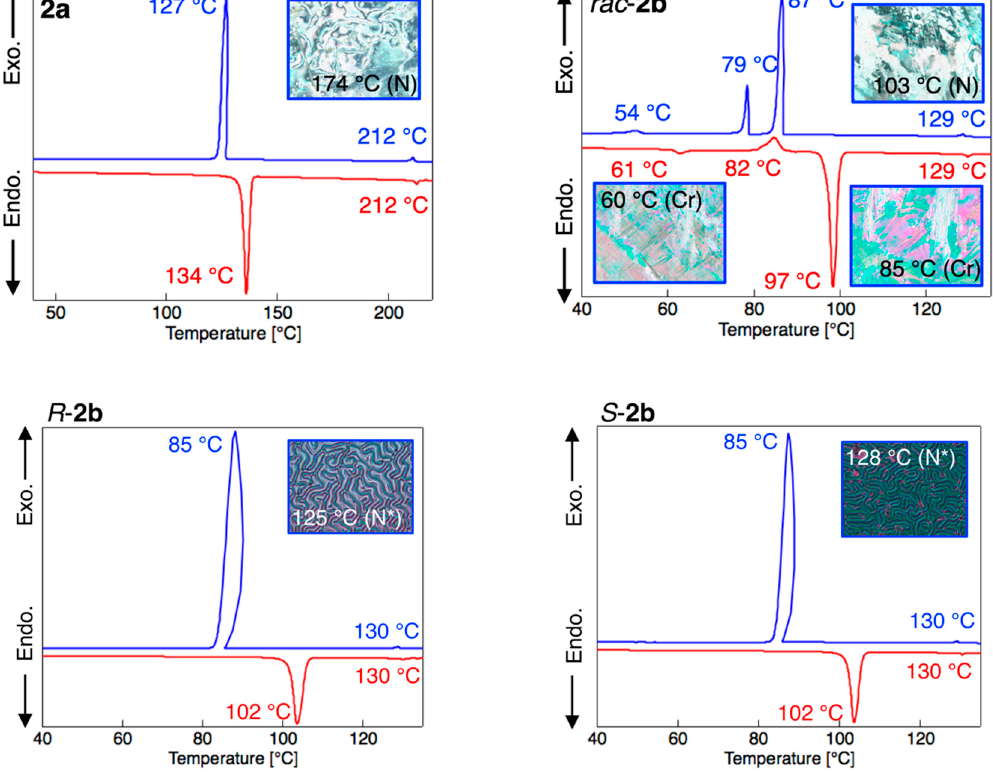
Figure 3. Di ff erential scanning calorimetry thermograms of 2a , rac - 2b , R - 2b , and S - 2b recorded during the second heating and cooling cycles. Microphotographs indicate optical textures of the selected crystalline and liquid-crystalline phases observed by polarizing optical microscopy. Cr: crystal, N: nematic, N*: chiral nematic, Iso: isotropic